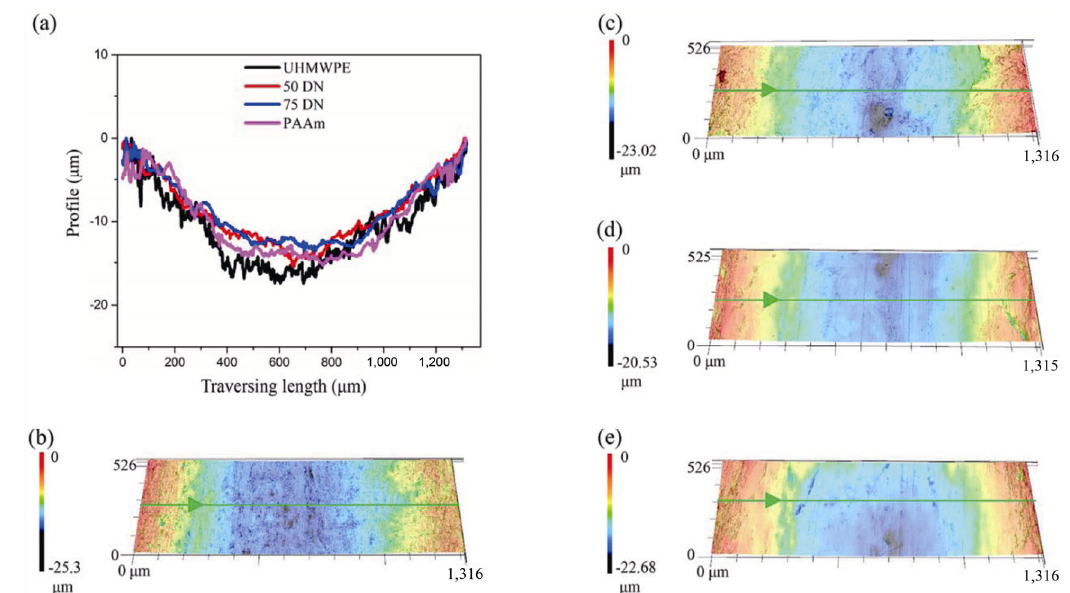
Fig. 11 (a) Cross-sectional profiles and (b–e) 3D wear surface topographies of the polymer discs under sliding velocity of